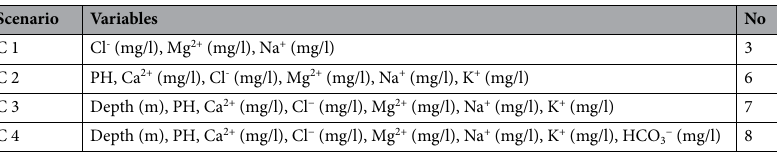
Table 2. Selected scenarios of candidate input components for modeling the salinity of groundwater obtained via Burota-random forest feature selection.